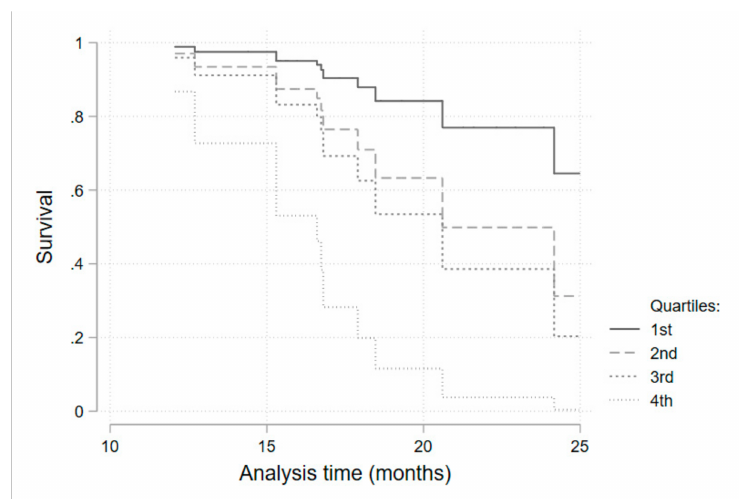
Figure 4. Kaplan–Meier survival curves for each quartile of serum iron